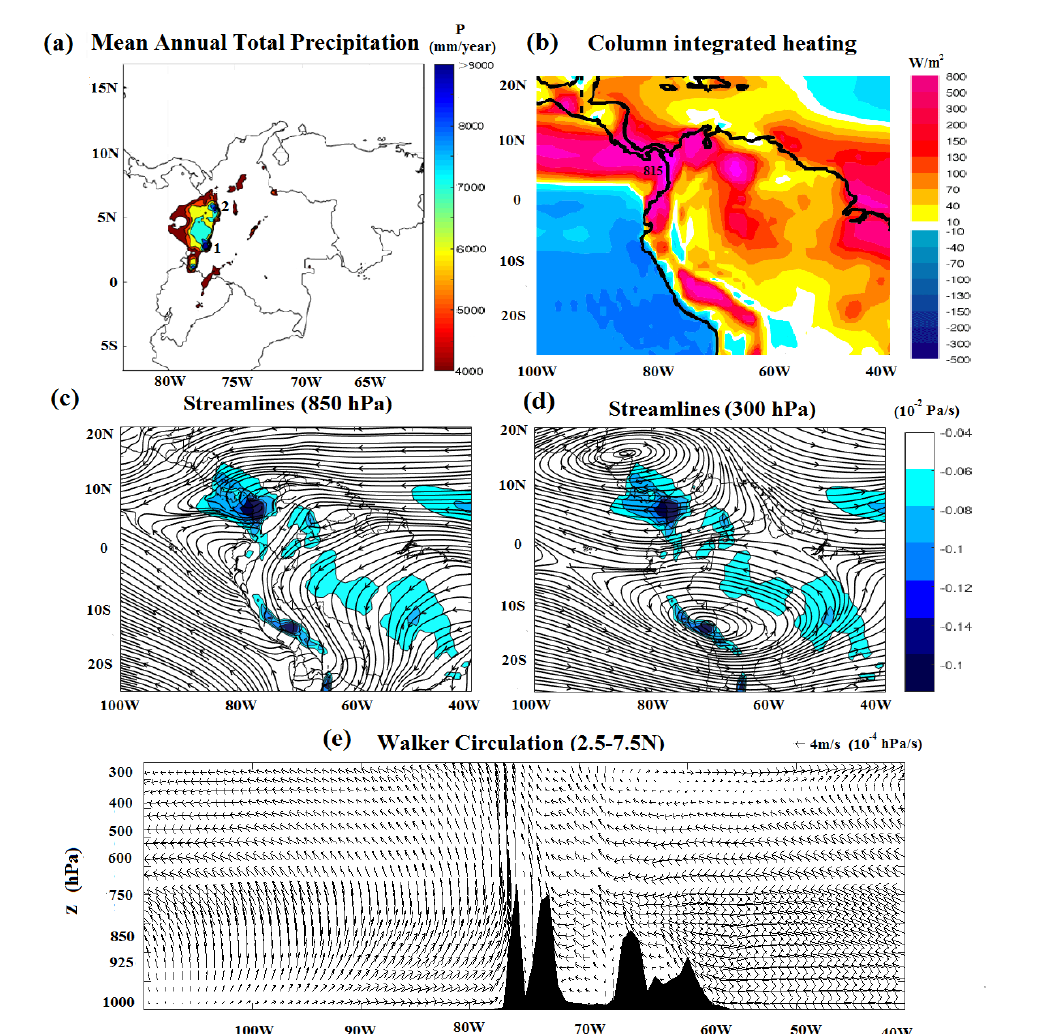
Figure 2. Average multiannual circulation in northern South America ( a ) Regions with precipitation above 4000 mm computed from Hurtado-Montoya and Mesa [25]. ( b ) Total column vertically integrated diabatic heating from ERA-40 Atlas [26]. ( c ) Streamlines at 850 hPa ( d ) Streamlines at 300 hPa. ( e ) Vertical cross section depicting the Walker circulation, taken from ERA-Interim